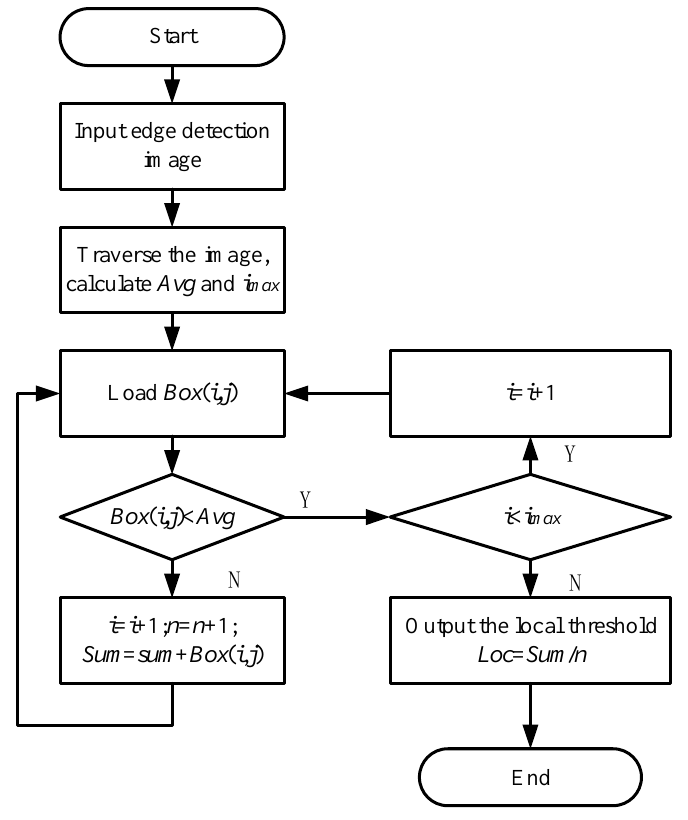
Figure 10. Flow chart of local threshold determination algorithm.